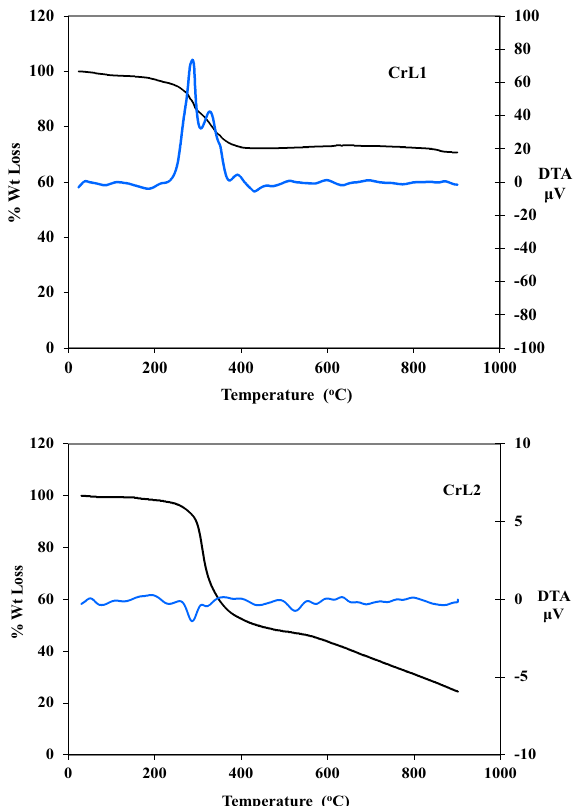
Figure 3. Results of a thermal study done on CrL1, and CrL2 complexes heated in air at a rate of 10 °C/min to 800 °C from room temperature to that